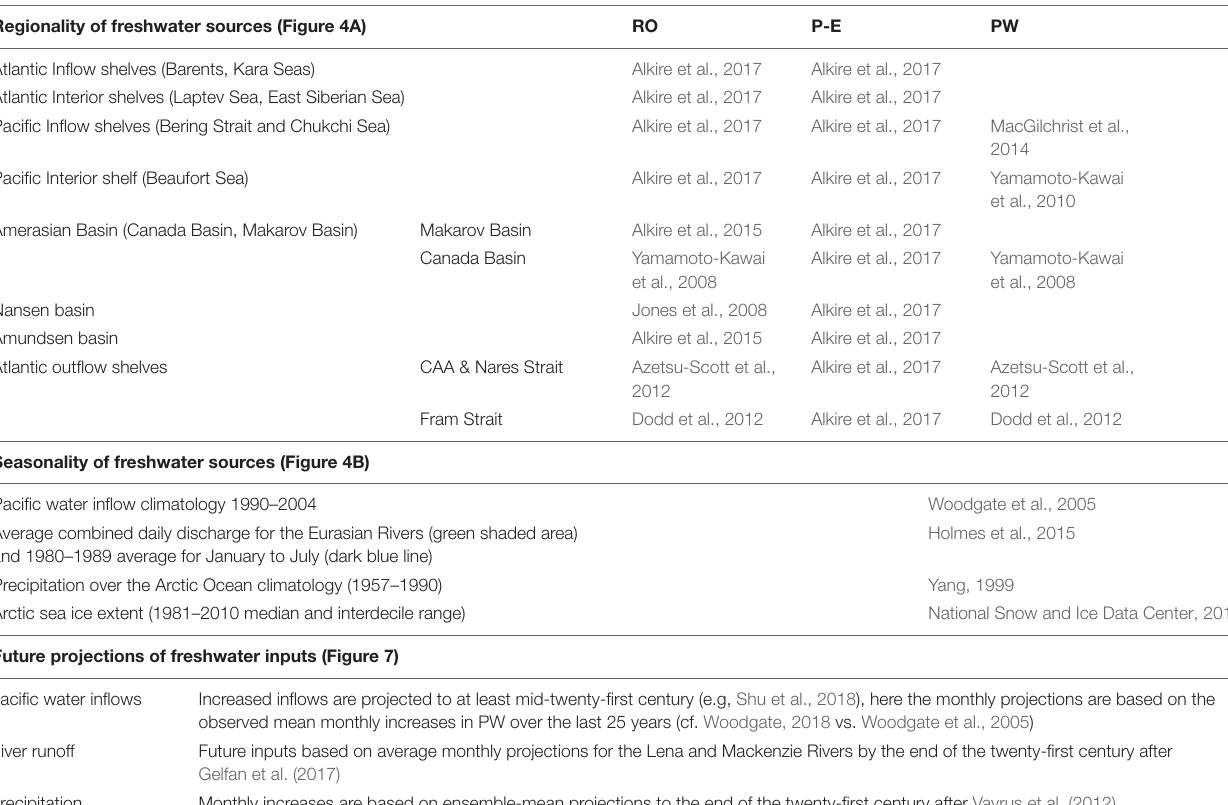
TABLE 3 | Regionality and seasonality of freshwater sources to the Arctic Ocean and projections for the future, literature sources for Figures 4 , 7 . Regionality of freshwater sources (Figure